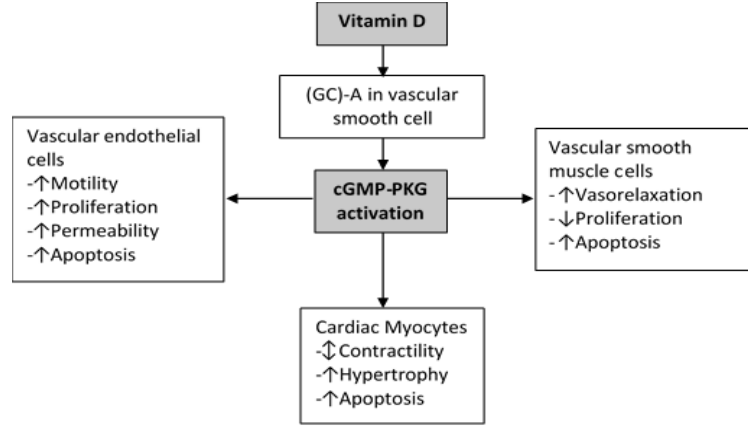
Figure 4. cGMP Activation Affects Cells Related to the Cardiovascular System